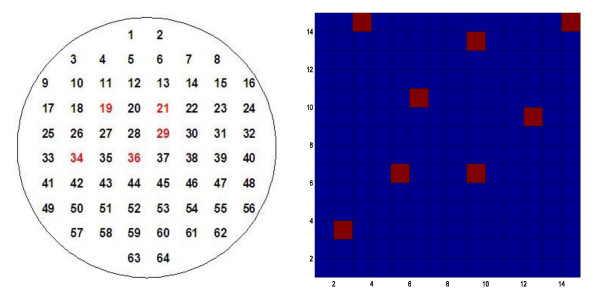
Left, hot-spots detected in 64-channel microelectrode array recordings from sheep temporal cortex during a face recognition task. Right results from a gene microarray experiment identifying significant expression changes in 8 out of 196 genes.